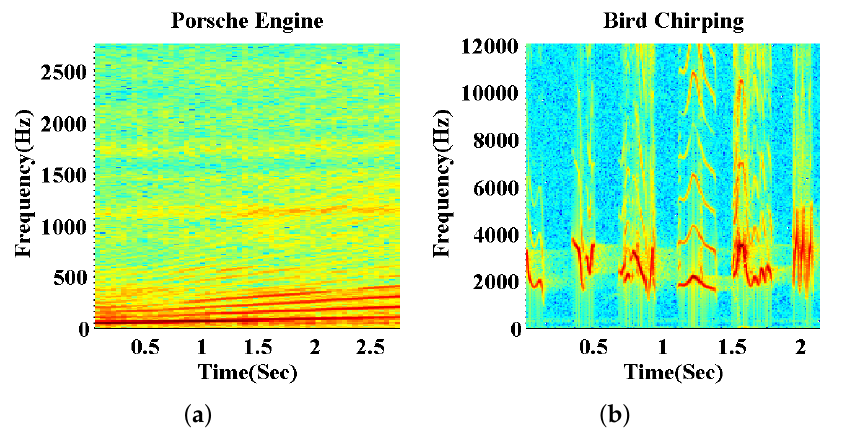
Figure 1. Spectrogram of ( a ) a Porsche engine and ( b ) a bird chirping.